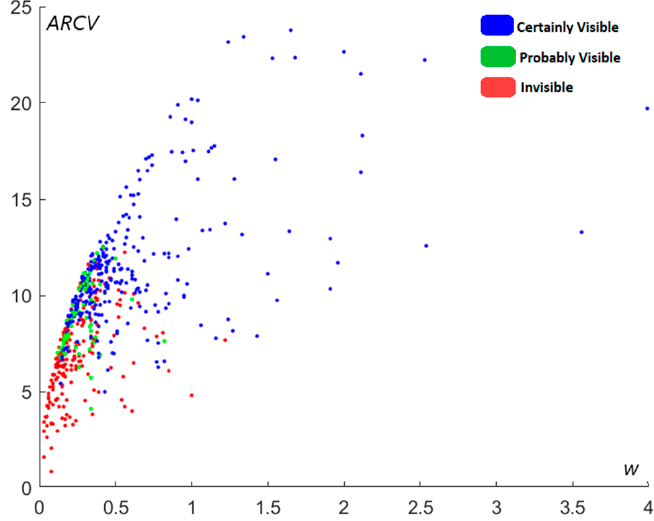
Figure 3. Distribution of the training dataset on a chart ( 𝐴𝑅𝐶𝑉 vs. 𝑤 ).